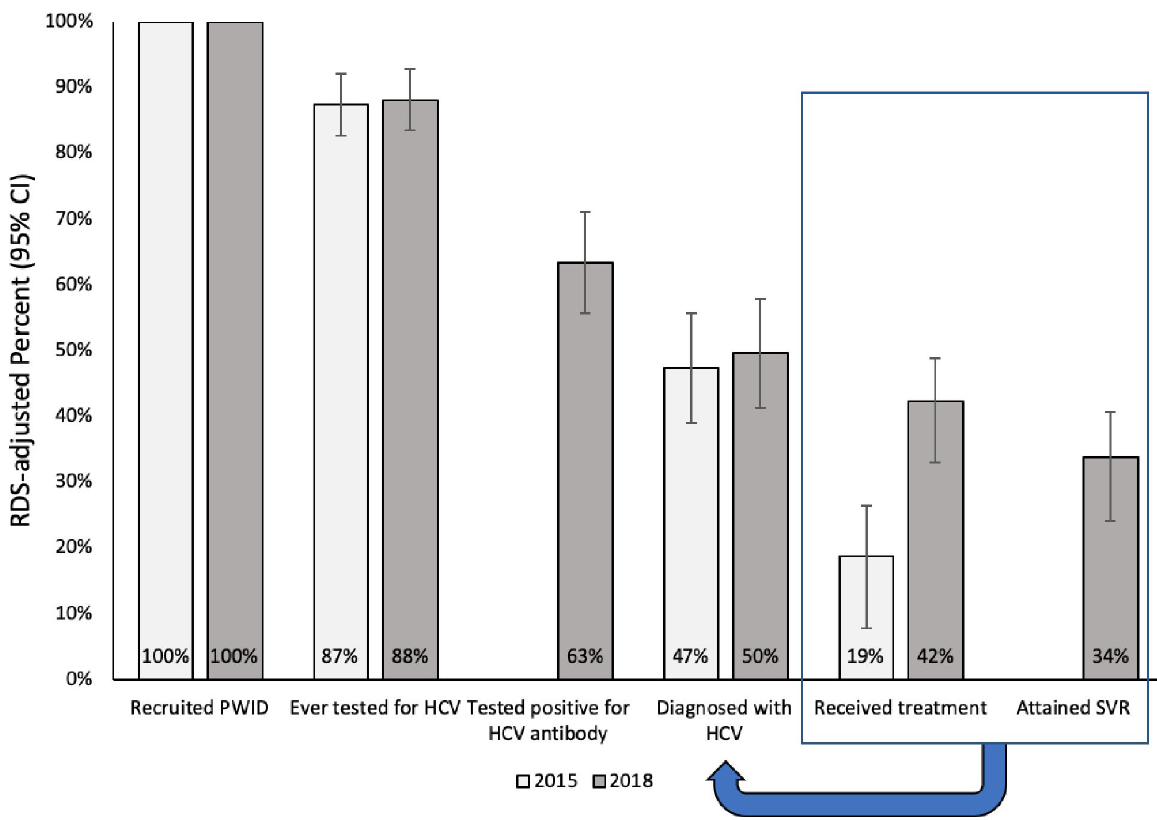
Fig 1. RDS-adjusted estimates for the Hepatitis C virus (HCV) infection treatment cascade in two rounds of surveys of people who inject drugs (PWID) in San Francisco, 2015 and 2018. Denominators for percent who received treatment and attained sustained virologic response (SVR) are those diagnosed with HCV infection. In 2015, tested antibody positive and attained SVR were not measured. The estimates in this graph are RDS-adjusted.